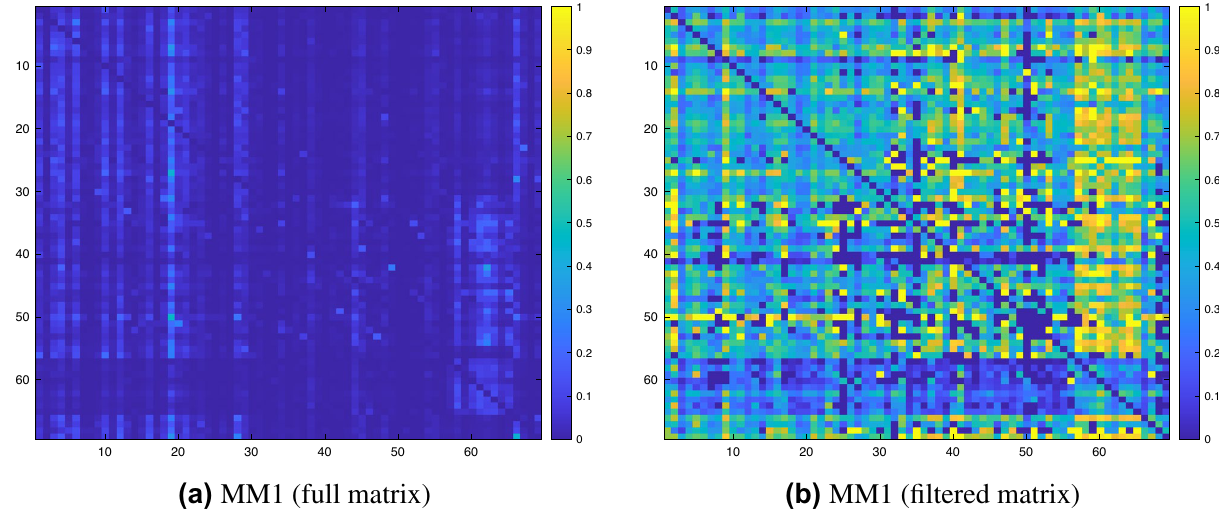
Figure 2. Each matrix entry, M ( i , j ), represents the conditional probability Pr ( patient = j | patient = i ) , ie., the probability that a patient is diagnosed with a disease j , given that they already suffer from disease i . The left panel plots data for all patients, while the right shows only those patients are considered who were diagnosed with both the diseases i and j . In other words, given that a patient has been diagnosed with both diseases i and j , how likely is that the patient was diagnosed with disease i before the patient was was diagnosed with disease j